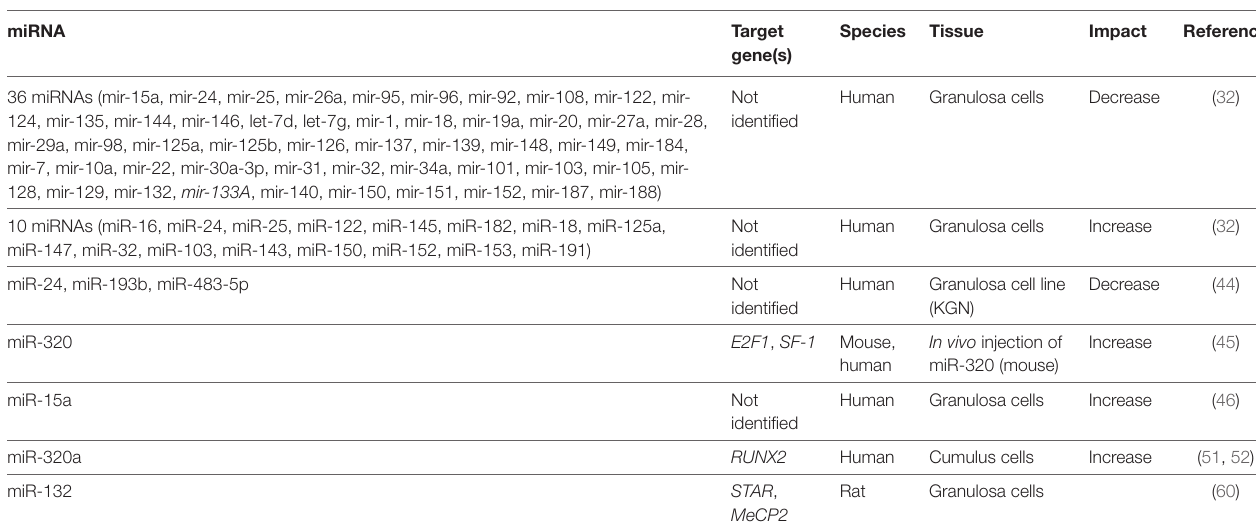
TABLe 3 | Progesterone-related microRNAs. miRNA